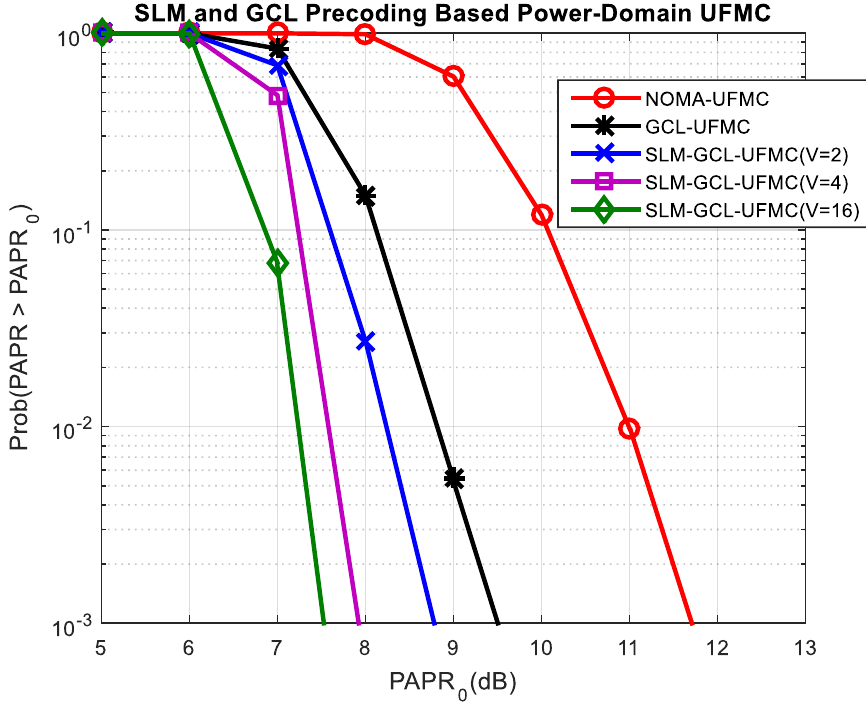
Figure 6. PAPR analysis using 256-QAM.